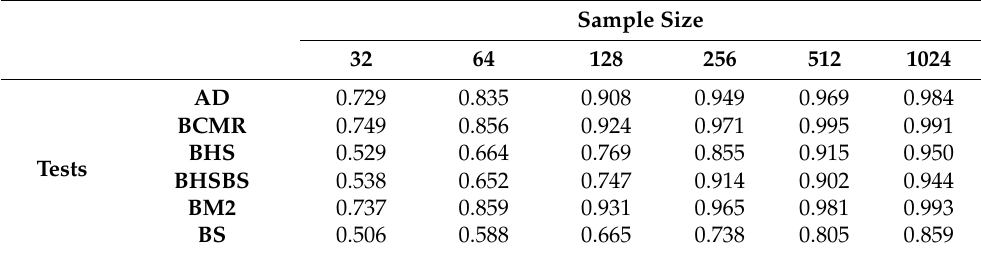
Table 2. Average empirical power obtained for a group of asymmetric